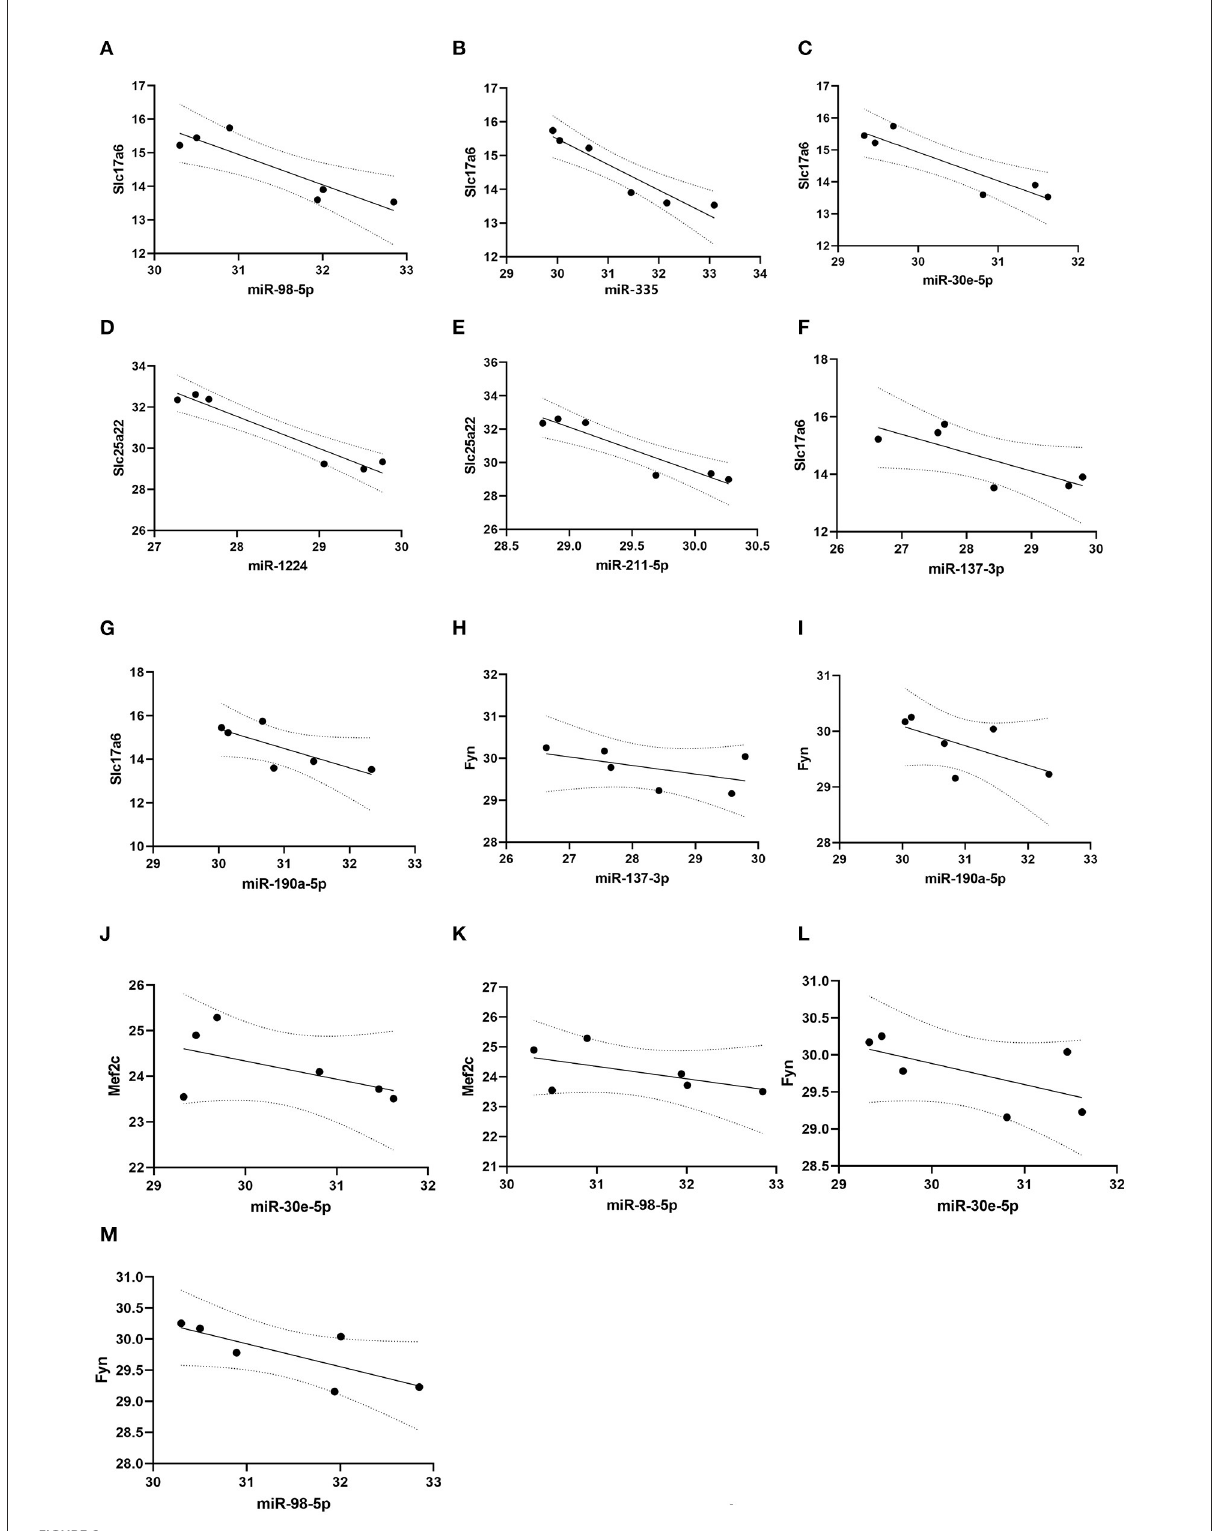
FIGURE6 Correlation analysis. Pearson correlation analysis was conducted to evaluate the correlation between microRNAs and glutamatergic-related mRNAs. (A–C) miR-98-5p, miR-335 and miR-30e-5p expression were significantly and negatively correlated with Slc17a6 expression; (D, E) miR-1224 and miR-211-5p expression were negatively correlated with Slc25a22 expression. (F–I) miR-137-3p and miR-190a-5p expression were no significantly and negatively correlated with Slc17a6 and Fyn expression. (J–M) miR-30e-5p and miR-98-5p expression were no significantly and negatively correlated with Mef2c and Fyn